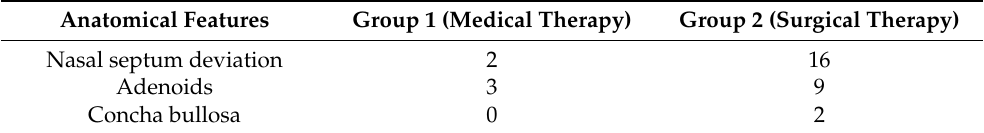
Table 3. Anatomical features in the two groups of patients. Anatomical